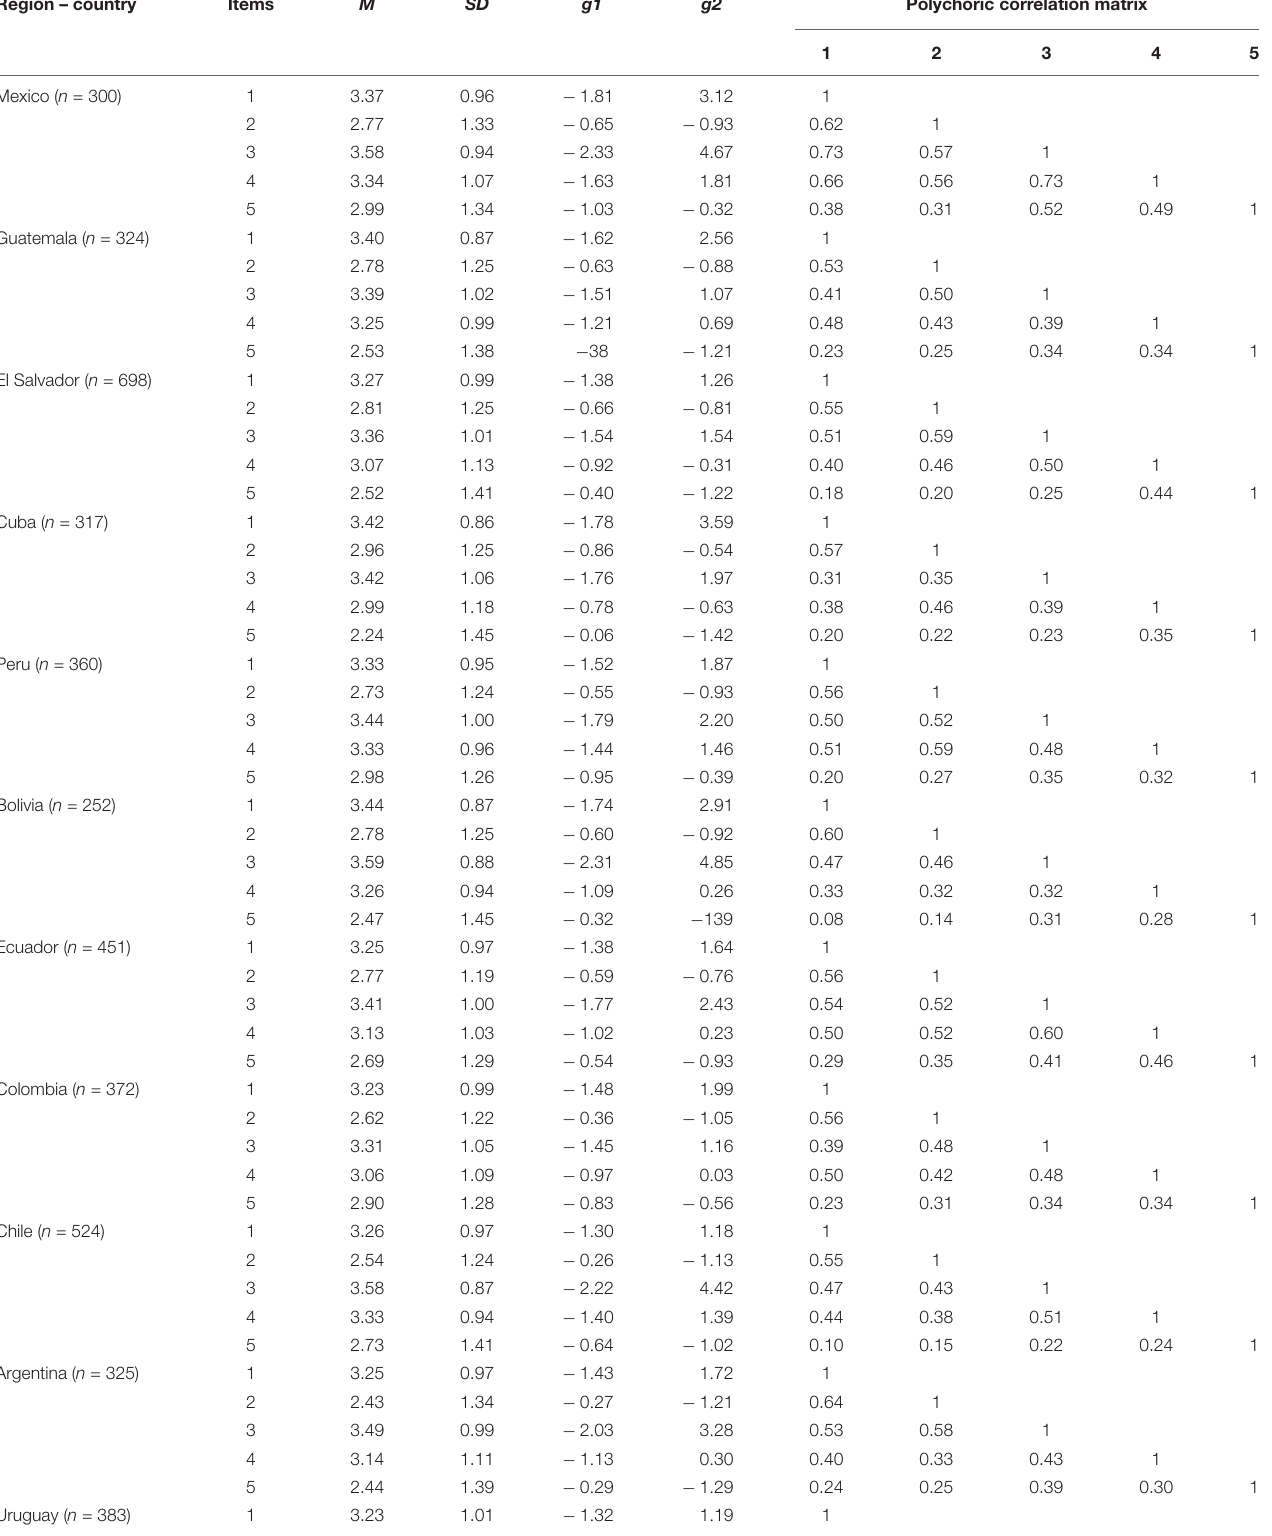
TABLE 3 | Descriptive analysis of the items and polychoric correlation matrix. Region –